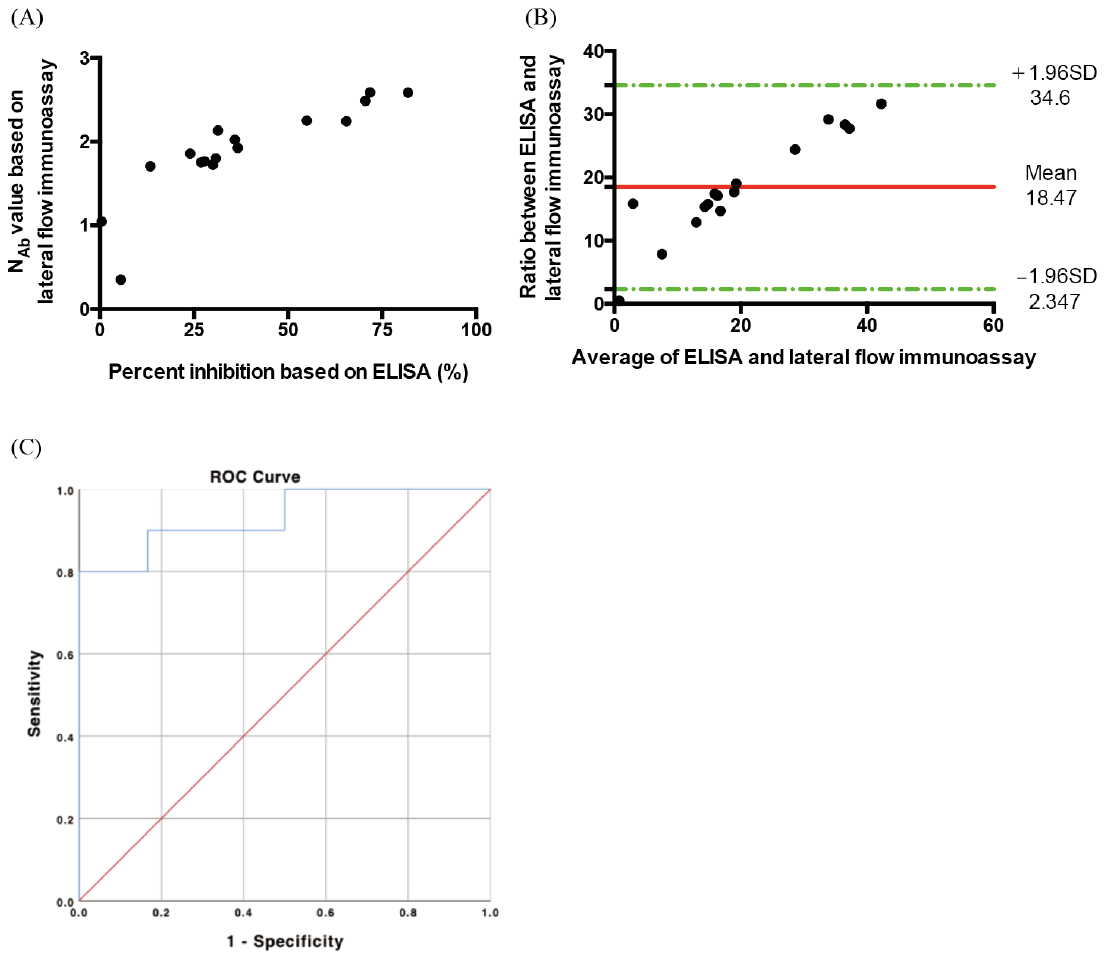
Figure 4. ( A ) Comparison of the lateral flow immunoassay and ELISA for the neutralizing antibody using plasma from vaccinated patients (Rho = 0.9818, p -value < 0.0001). The x -axis is the unit of percent inhibition based on ELISA. The y -axis is the unit of N Ab value based on the lateral flow immunoassay. ( B ) Bland and Altman plot. The ratio between the neutralizing antibody based on the lateral flow immunoassay and ELISA in relation to the mean of the two measurements ( n = 16). Green lines indicate the limits of agreement ( ± 1.96 standard deviation). ( C ) ROC curve of the neutralizing antibody concentration in COVID-19-vaccinated cases based on the lateral flow immunoassay and ELISA ( n = 16) (AUC = 0.933, p <